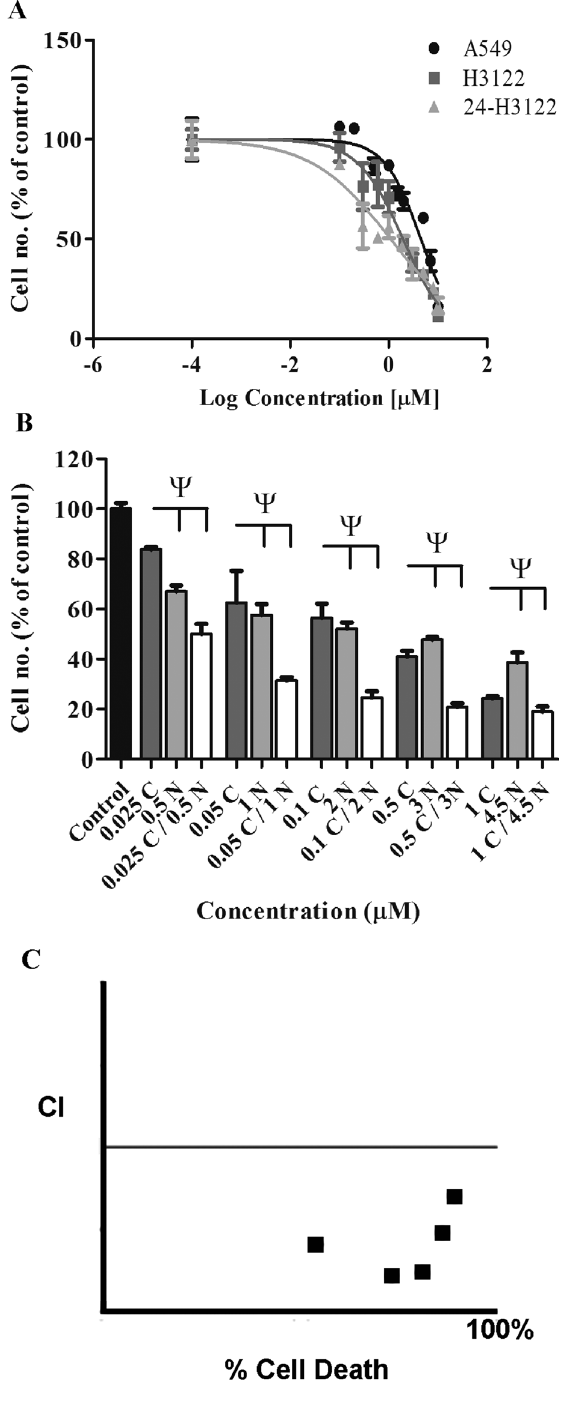
Figure 3. Effect of 24 hr exposure of NSCLC cells to crizotinib (10 μ M) on drug cytotoxicity at 12 days post- treatment. ( A ) Cytoxicity for IGF-1R inhibitor NVP-AEW541 on ALK-negative A549 cells, ALK-positive H3122 cells, and crizotinib-exposed cells (24-H3122). ( B ) Cytotoxicity of combination treatment by crizotinib and NVP-AEW541 on 24-H3122 cells. ( C ) Combination index plot for drug combinations in “B”. Conventions are as for Fig.